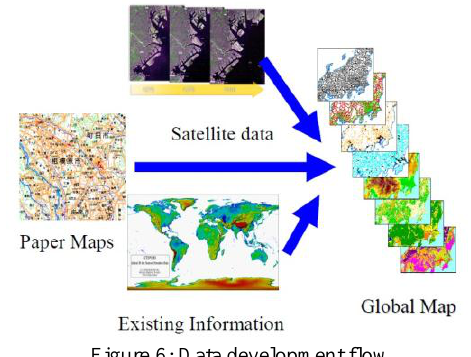
Figure 6: Data development flow